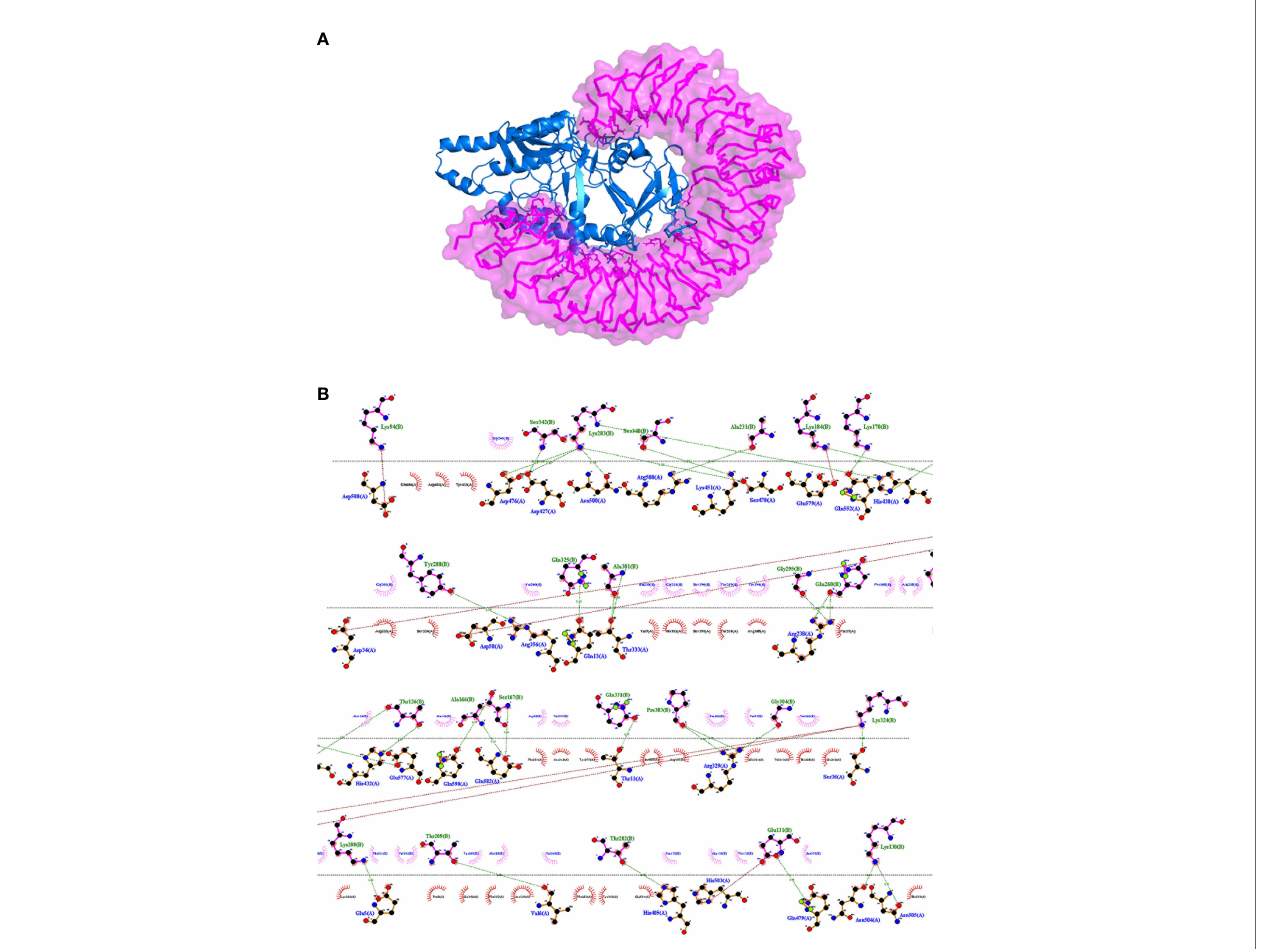
FIGURE 5 | (A) Representation of a docked complex of the vaccine construct and TLR4 shown as a marine blue cartoon and a magenta surface , respectively. (B) Two-dimensional representation of the interactions between the vaccine construct and TLR4. Red dotted lines represent salt bridges and green dotted lines represent hydrogen bonds. The residue in TLR4 PDB is renumbered from 1. The start residue 27 in TLR4 PDB is represented as